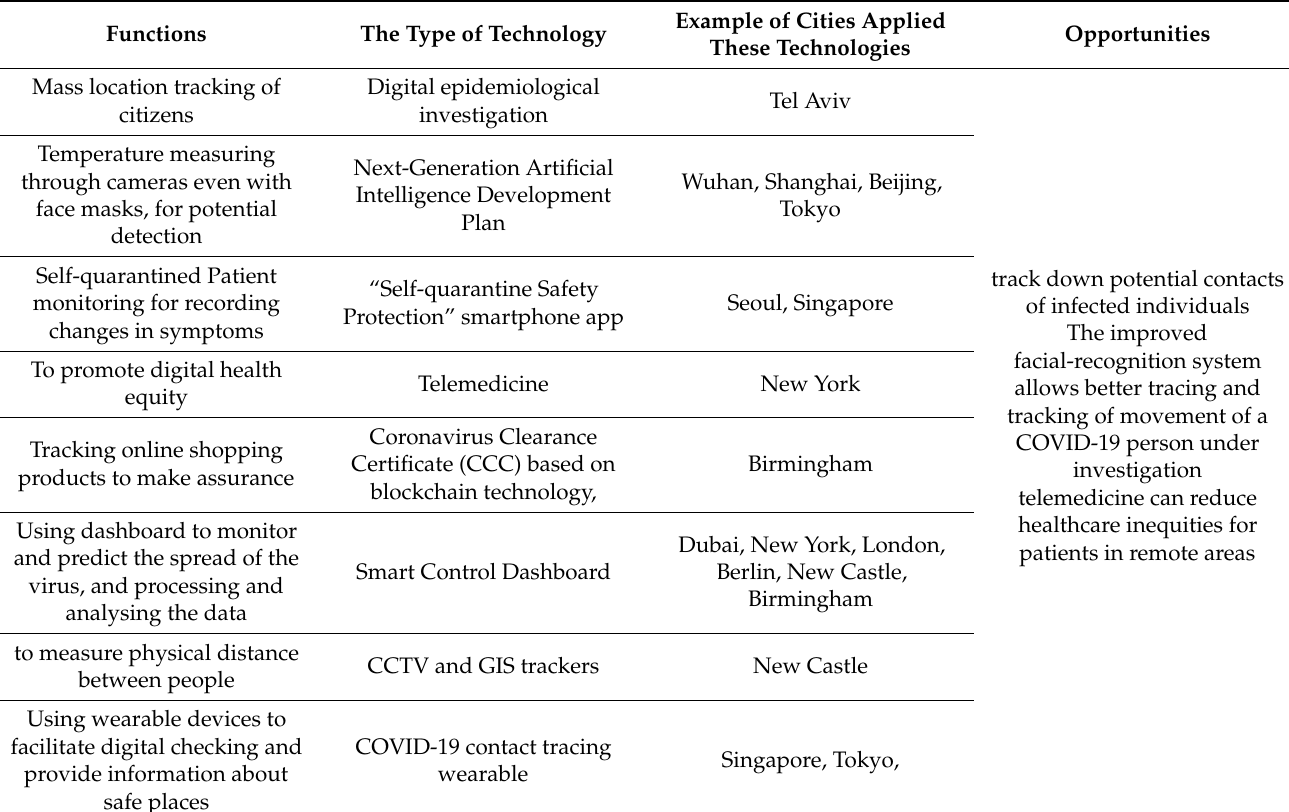
Table 2. Technology deployment and functions to improve the physical and mental health of residents during COVID-19.